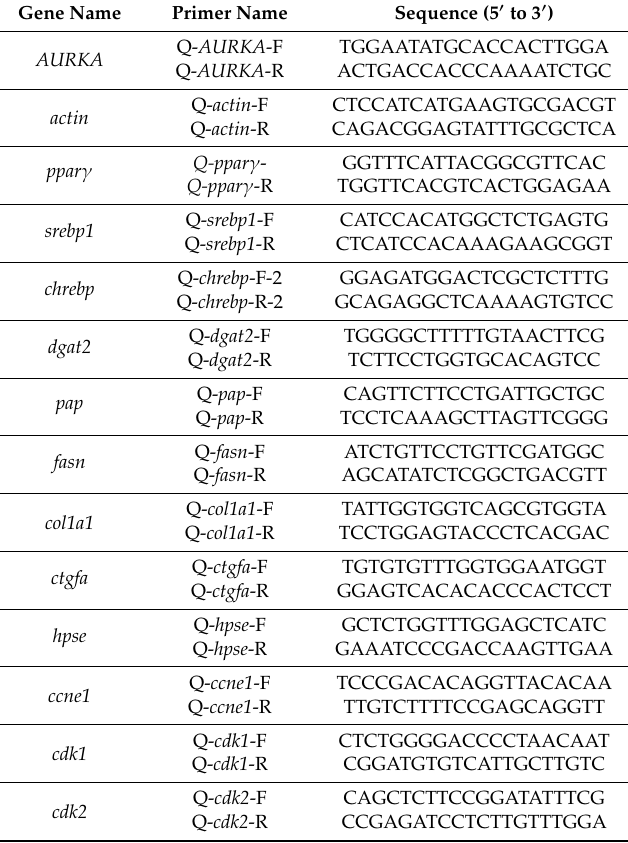
Table 1. Primer sequence of qPCR for human AURKA , zebrafish actin , lipogenic factors ( ppar γ , srebp1 , chrebp ), lipogenic enzymes ( dgat2 , pap , fasn ), fibrosis markers ( col1a1 , ctgfa , hpse ) and cell cycle related genes ( ccne1 , cdk1 , cdk2